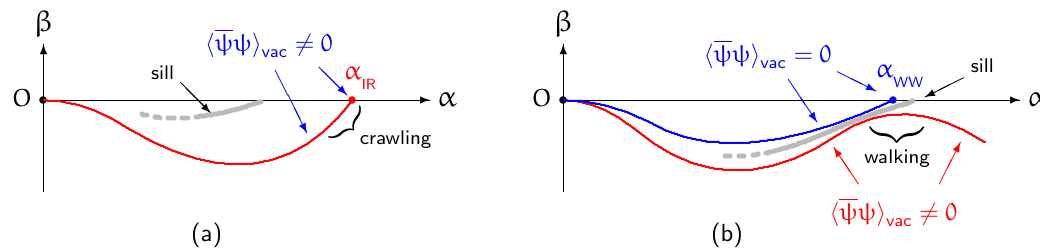
Figure 3. Graphs of the TC β function in SU ( 3 ) gauge theories with N f Dirac flavors for ( a ) crawling TC and ( b ) walking TC. On each graph, the sill of the conformal window at N c flavors is shown as f a thick gray line. In ( a ), there is a genuine massless dilaton at α IR outside the conformal window ( N f (cid:54) N c ), so large scales are possible at that point. Small-scale corrections such as m h = 125 GeV for f the Higgs boson mass occur for α (cid:46) α IR . In ( b ), the physical theory below the sill (red line, N f (cid:54) N c ) is f scale-dependent and lacks an IRFP. The theory above the sill and hence inside the conformal window < N (blue line, N c f (cid:54) 16) is scale-free and has an IRFP α WW with conformal invariance in WW mode. f The sill generates all scales in the physical theory, both large and small, no matter how closely the red Λ 2 line in the walking region approaches α , with the walking α evaluated at a space-like scale . TC WW ∼ − Therefore, a type-III “dilaton” is unlikely to be